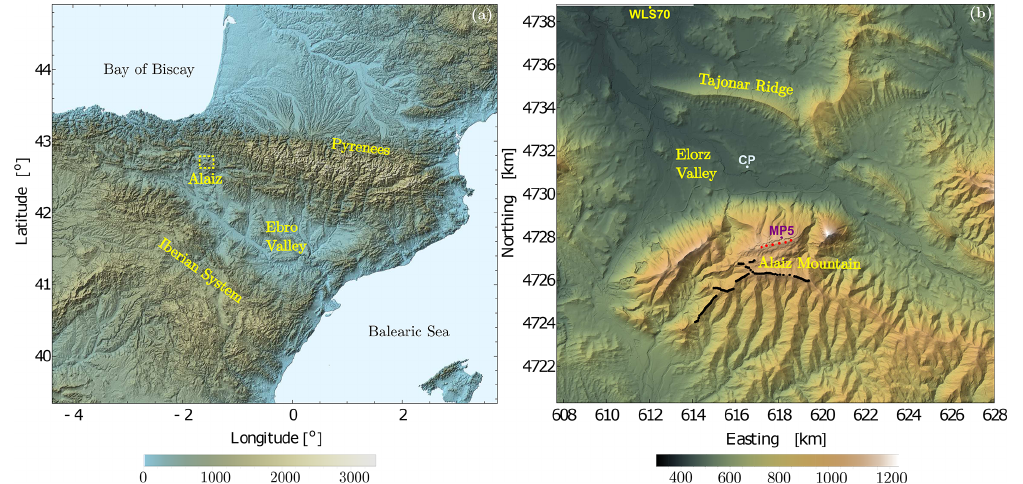
Figure 2. Location and overview of ALEX17. Panel (a) shows the experiment location (yellow rectangle) within the Iberian Peninsula. The experiment is shown in panel (b) , with CENER’s wind turbine test stands (red) and reference MP5 meteorological mast (purple), Acciona’s wind farms (black), and the central position (CP, light blue) and a profiling wind lidar (WLS70, yellow). The color bars represent the height above mean sea level in meters based on digital elevation models from SRTM (a) and lidar aerial scans (b) in UTM30 WGS84.